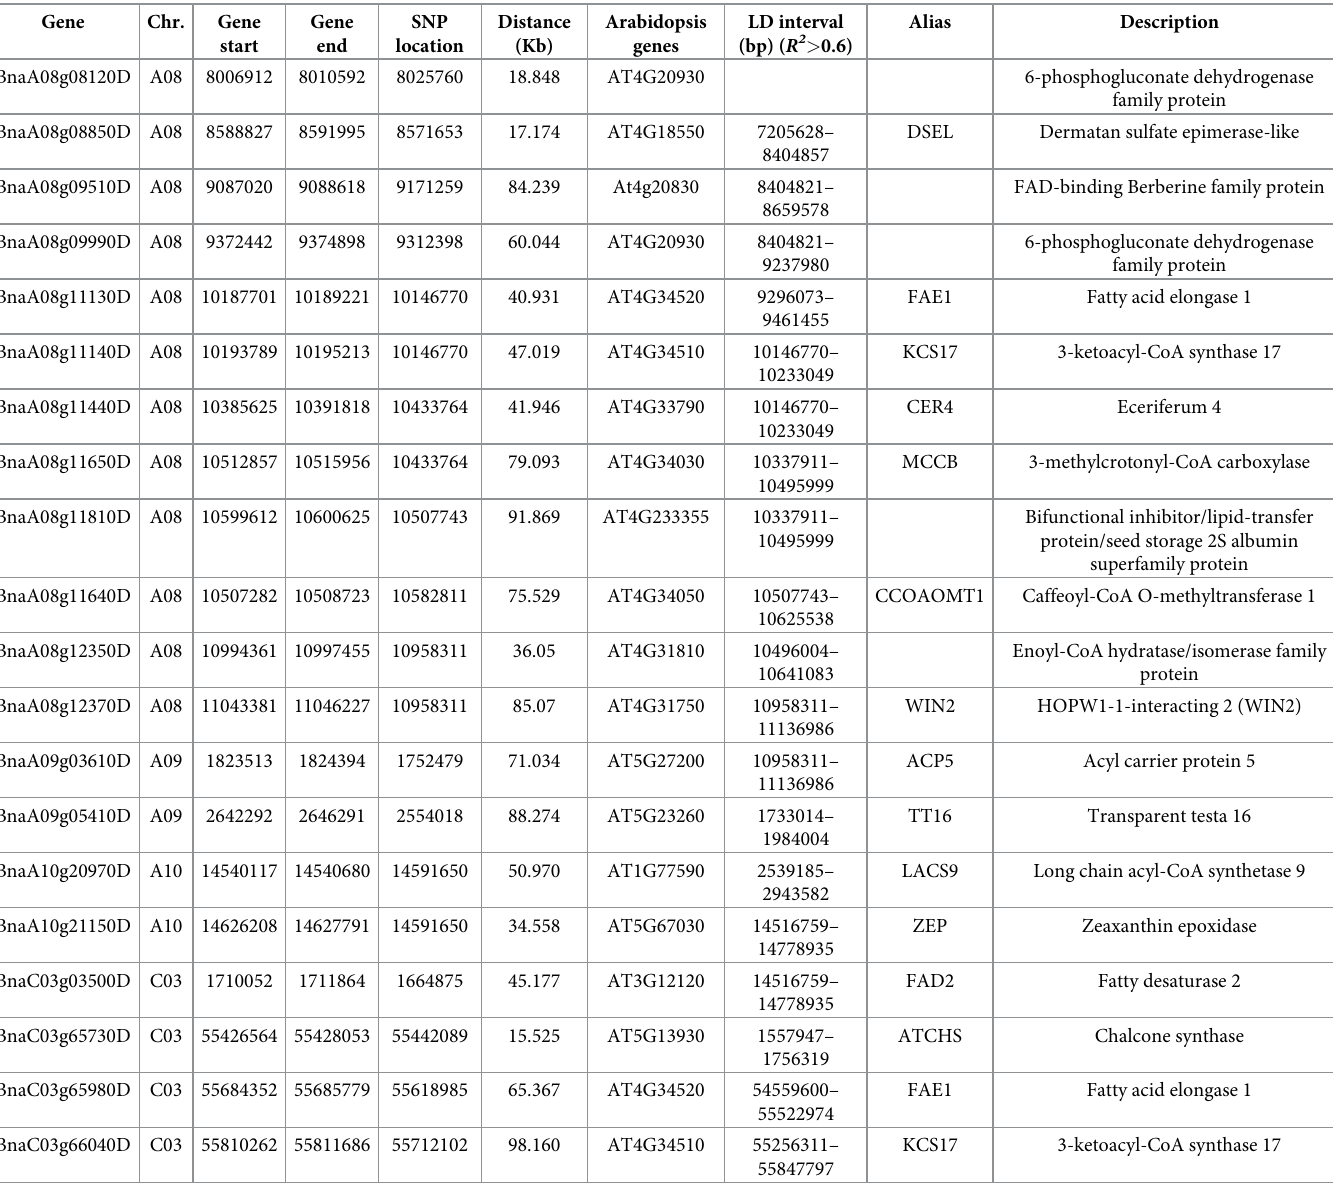
Table 6. Candidate genes tagged by the associated SNPs with fatty acid biosynthesis and metabolism in B . napus and their orthologs in A . thaliana . Gene Chr.